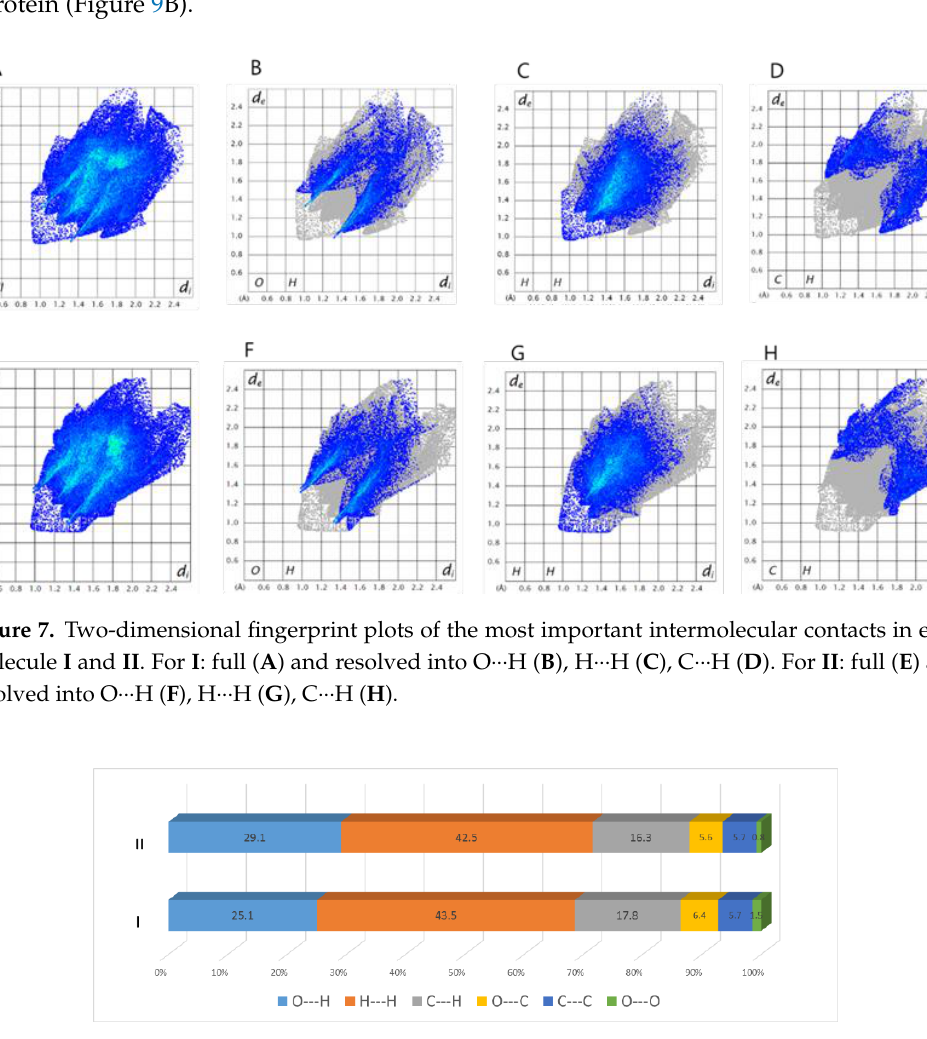
Figure 6. ( A ) Hirshfeld surfaces of molecule 5I mapped with d norm , shape index and curvedness. ( B ) Hirshfeld surfaces of molecule 5II mapped with d norm , shape index and curvedness.